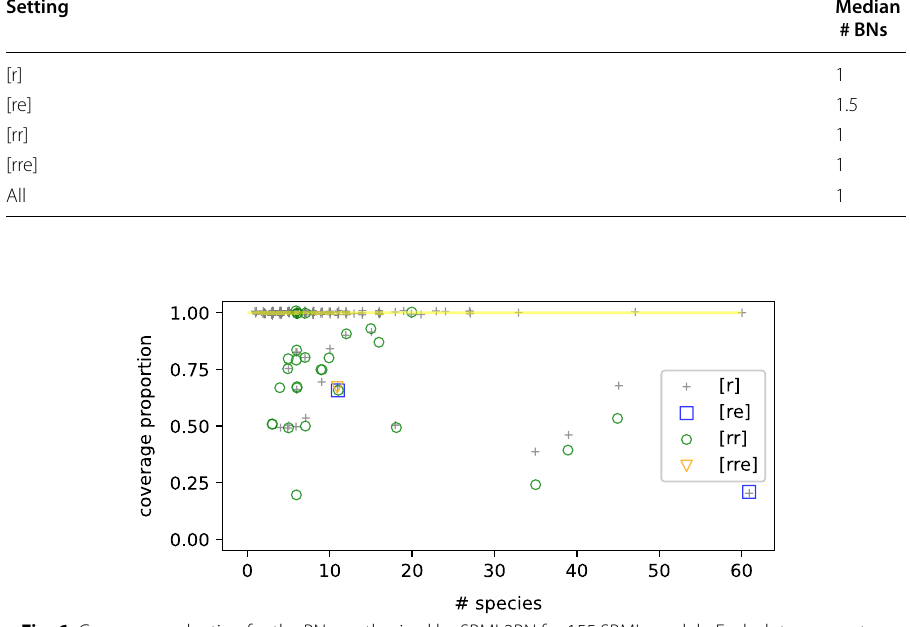
Table 3 Number of BNs generated, coverage and number of clauses Setting